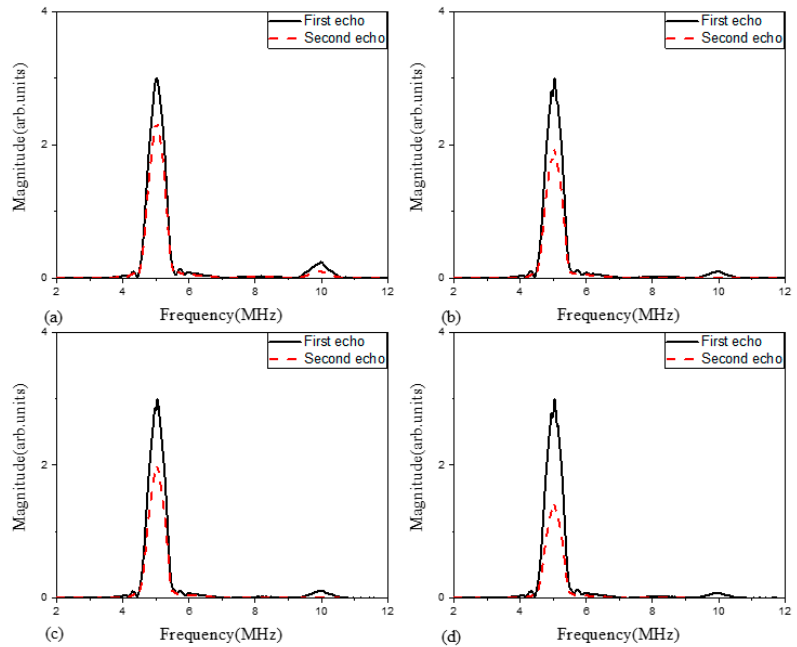
Figure 7. Spectrums of ultrasonic testing results for copper plates at four different stages: ( a ) raw material, ( b ) sample after annealing at 600 °C for 12 hours, ( c ) sample after re-cold rolling, and ( d ) sample after re-annealing at 600 °C for 12 hours.